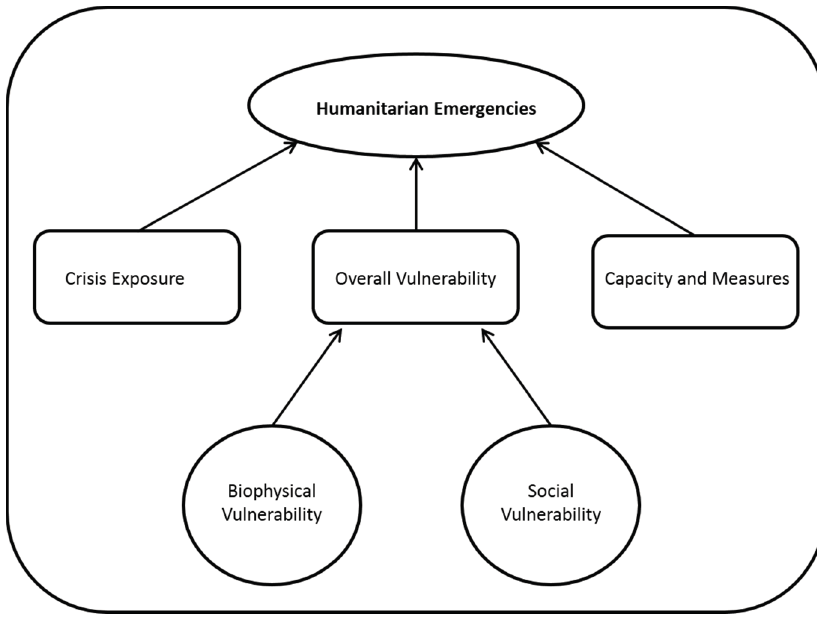
Figure 1. Humanitarian Crisis